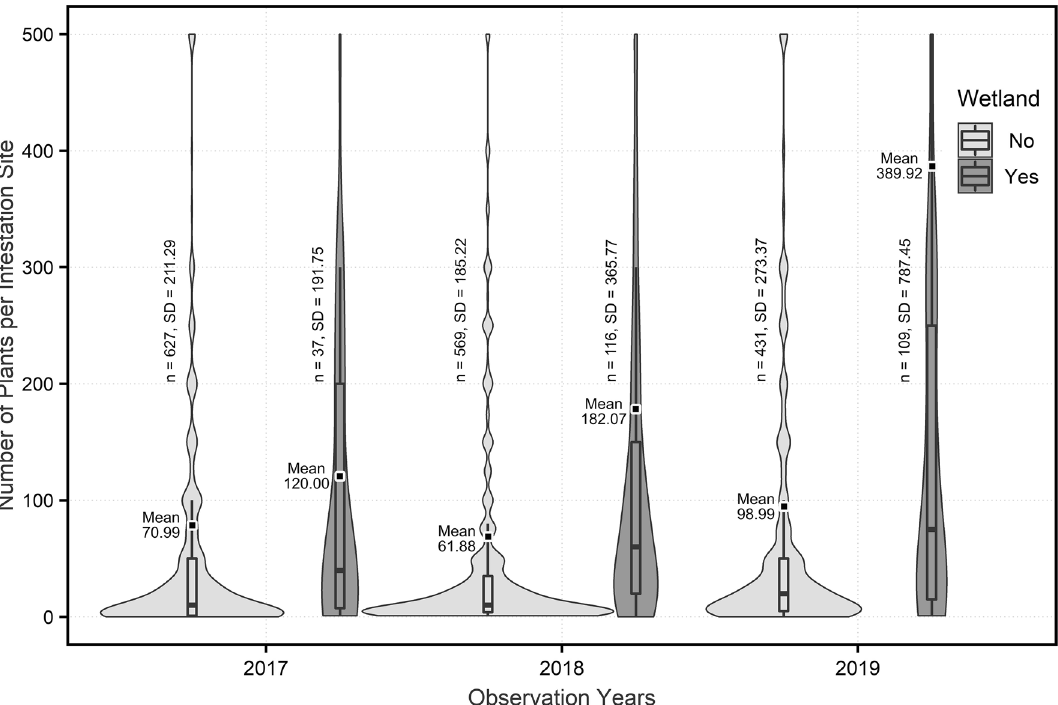
Figure 2. Annual changes in number of plants inside wetland areas and outside wetland areas (Wider areas represent higher number of infestation sites, n = number of observations, SD = Standard Deviation, box plots represent medians and quartiles, and the dots represent means). Figure created in RStudio v9.1.372 36 using R v4.1.2 37